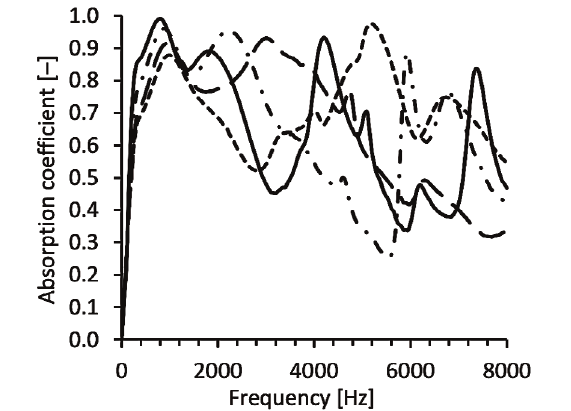
Fig. 15. For double-layer set-up for material B, distance X1 was set to 30 mm and distance X2 was varied from 5 mm (dashed line) to 50 mm (solid line).